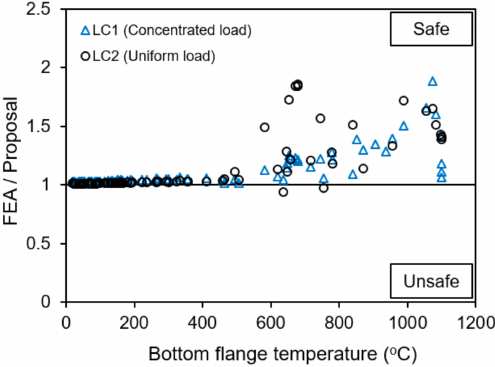
Figure 17. Accuracy of reduction factor obtained from FEA compared to new